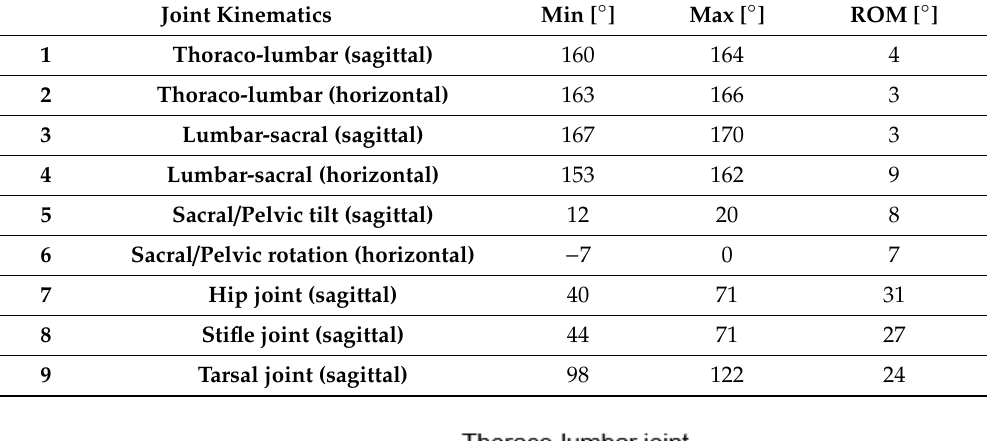
Table 3. Minimum (min), maximum (max), range of motion (ROM) joint kinematics values (in degrees ( ◦ )) averaged over gait cycles and subjects and their standard deviation values for 9 di ff erent joints with respect to the planes reported in parentheses.